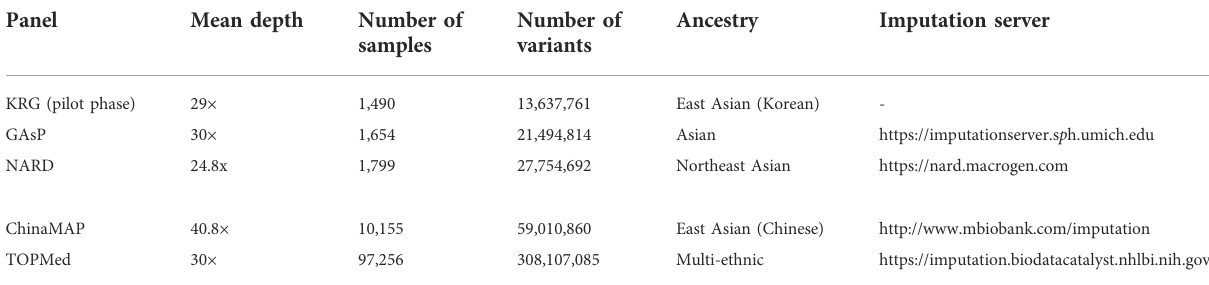
TABLE 2 Characteristics of reference panels used in this study.